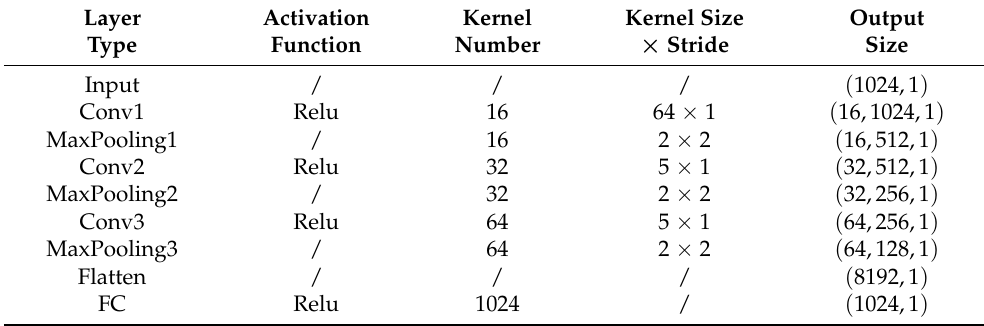
Table 1. The structure of the feature generator